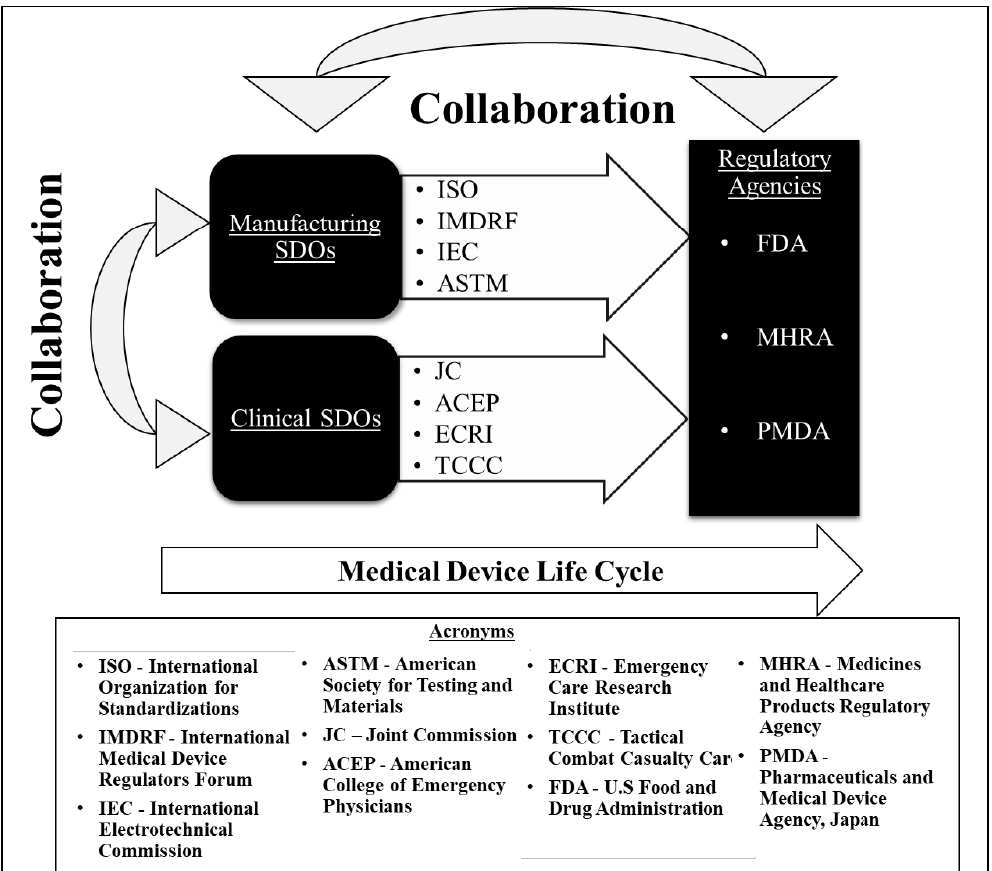
Figure 2. Ecosystem of Standards. Reprinted with permission Idealized depiction of the inter-relationships informing medical device standards. The organizations depicted are examples relevant to suction devices and will vary with the device examined.